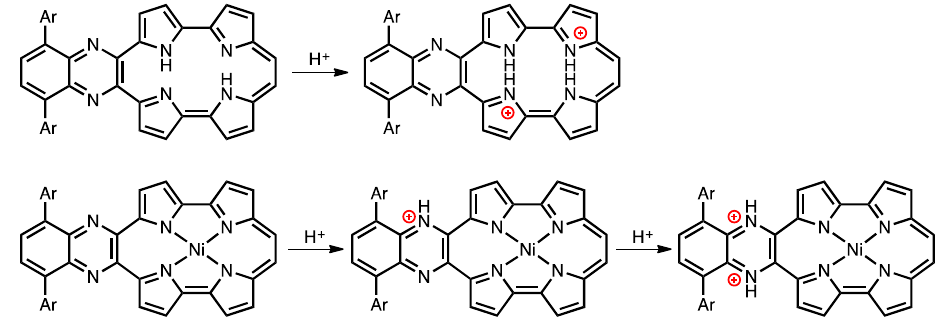
Figure 8. The TFA titration of the absorption spectra of ( a ) 1a-H 2 , ( b ) 1a-Ni , ( c ) 1b-H 2 and ( d ) 1b-Ni in CH 2 Cl 2 . Inset: absorbance changes at ( a ) 405 (red) and 667 nm (blue); ( b ) at 411 nm; ( c ) 397 (red) and 665 nm (blue), and ( d ) 407